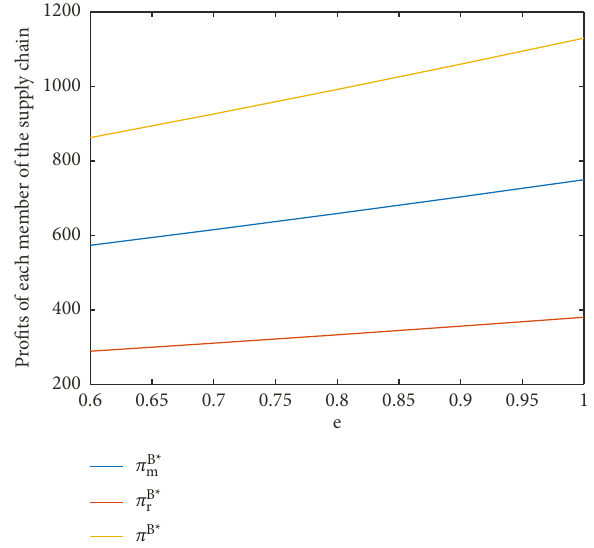
Figure 3: The impact of e on supply chain profits. Table 4: The impact of organic degree e on supply chain profits.